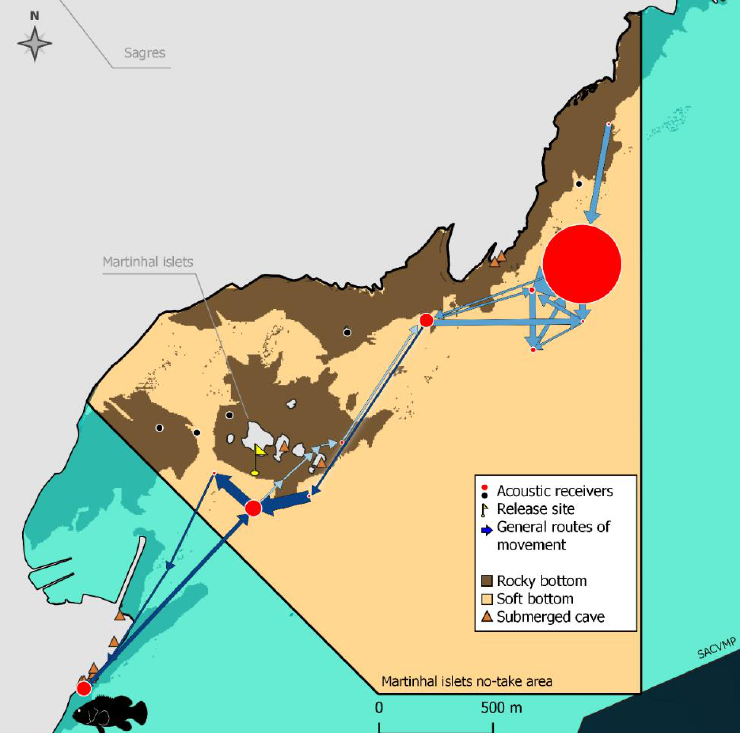
Figure 8. General routes of short-distance ranging movements of G29 in the Martinhal islets study area. Nodes represent acoustic receivers (with detections — red; without detections — black) and the size of the circles are proportional to the number of detections logged in each receiver. The edge’s thickness is proportional to the number of movements between two nodes and arrows represent the direction of the predominant movement directionality. The three shades of blue of the arrows reflect the time sequence of tracked ranging movements: the lighter blue arrows represent the movements within the first four days after release, the darker ones represent the ranging movements in the last five days of presence, and the arrows with intermediate color represent the movements performed between the two periods. The dusky grouper silhouette represents the location where G29 was detected for the last time. The light blue indicates buffer areas of the marine park (SACVMP).